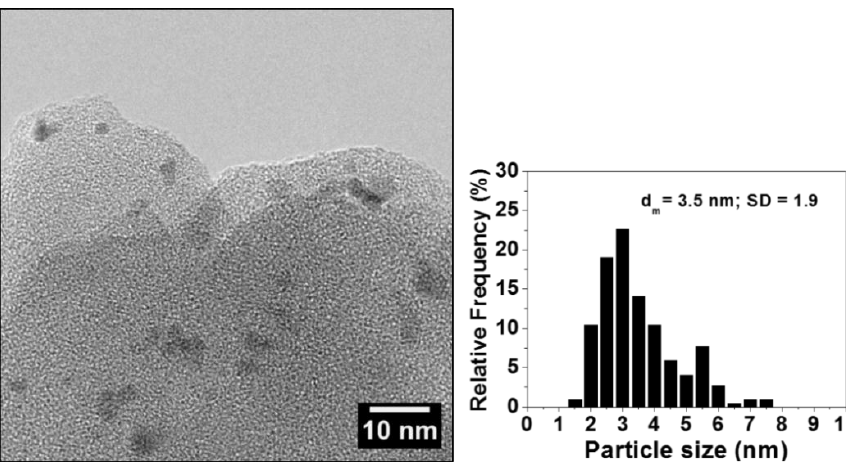
Figure 3. Recycling tests on Pd / PVPy catalysts for the Suzuki–Miyaura coupling reaction of 4-bromotoluene ( 1a , black bars) and 4-bromonitrobenzene ( 1b , grey bars) with phenylboronic acid ( 2a ) (see Table 2 for experimental conditions).